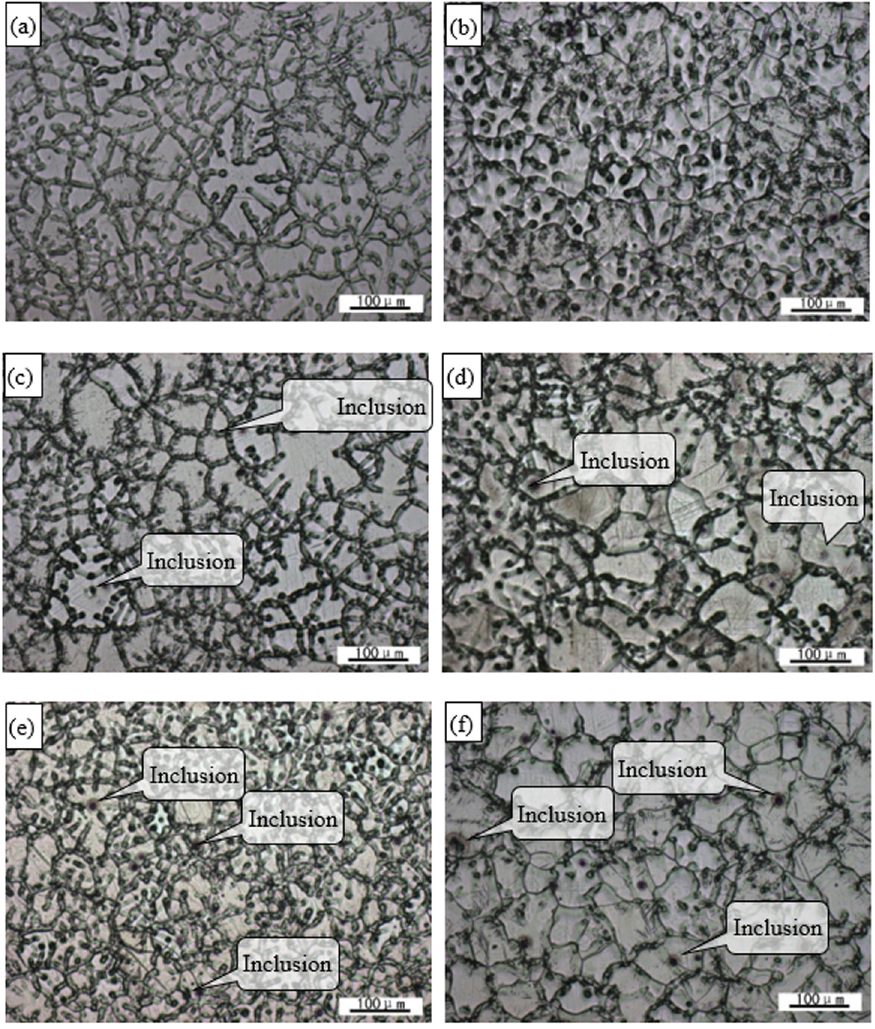
Figure 2. Optical microstructure of various GWK alloys from the center and edge of ( a , b ) GWK-a ingot; ( c , d ) GWK-b ingot; ( e , f ) GWK-c ingot.